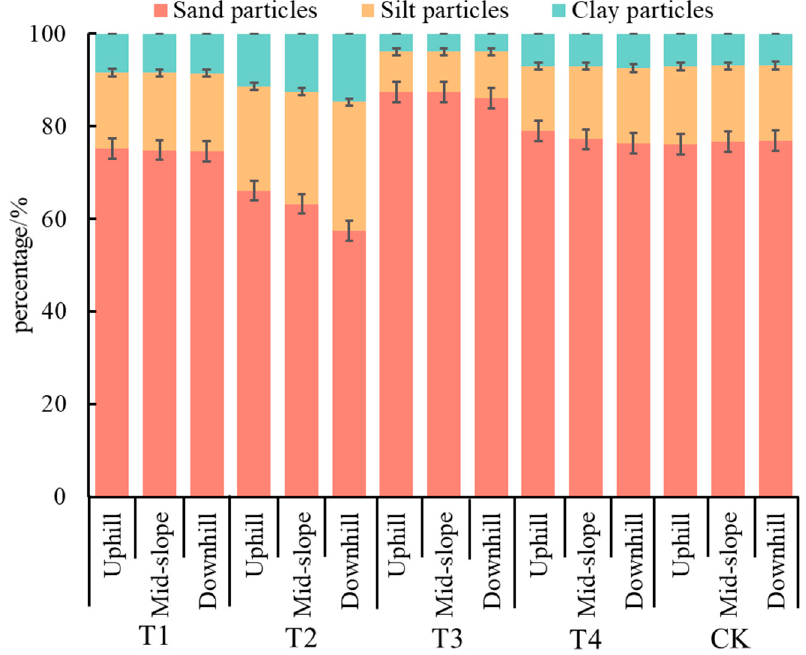
Figure 1. Proportions of sand particles, silt particles, and clay particles under different hedgerow patterns.